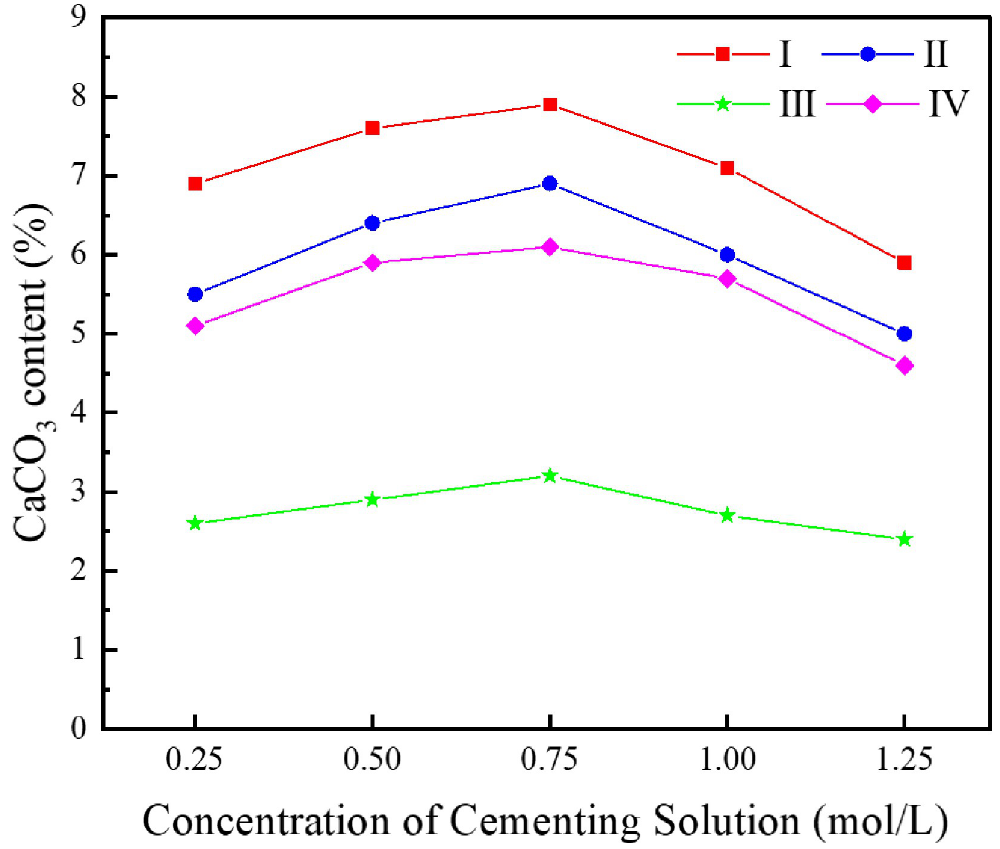
Fig 11. Relationship between cementing solution concentration and CaCO3 content in each